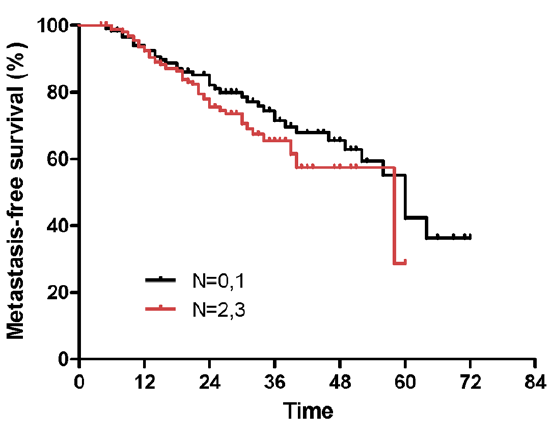
Figure 4. Kaplan-Meier estimates of metastasis-free survival for patients with N stage being 1 or 2 versus 3 or 4.